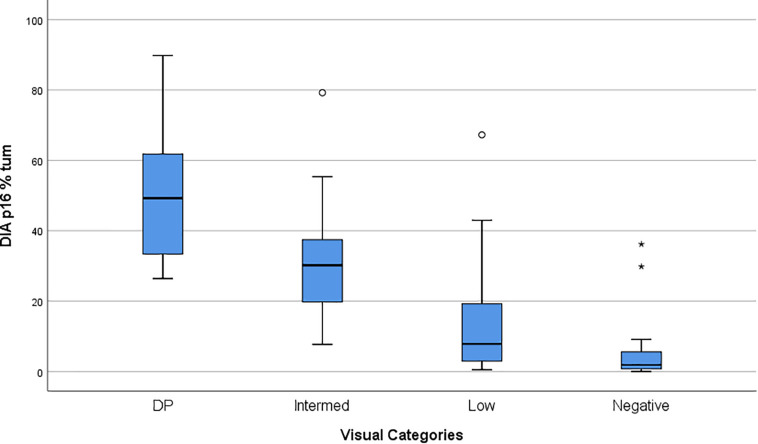
Box Plot showing the P16INK4a Visual Categories compared to P16INK4a expression quantified by DIA (Digital Image Analysis). Values on the Y-axis are% of UM tumor cells positive to P16INK4a.